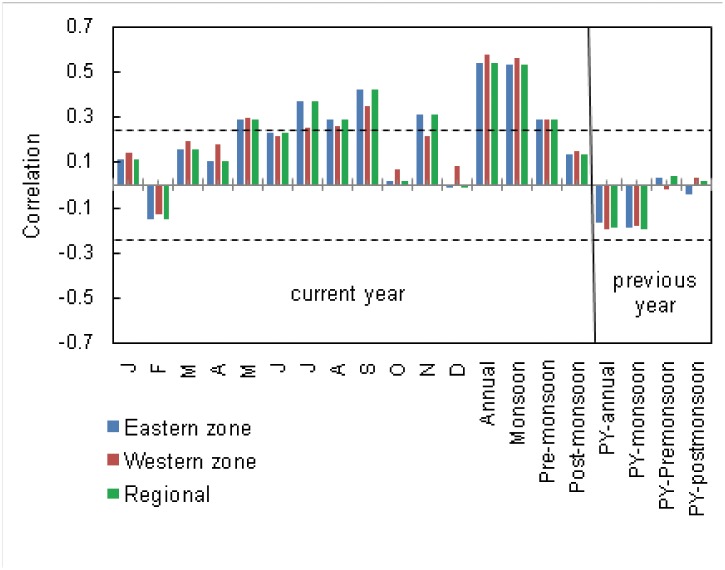
Correlation coefficients between the tree-ring chronologies and precipitation data (1948–2011).The chronology of eastern and western zone was correlated with precipitation of Khulna and Shakhira district, respectively. The regional chronology was correlated with regional (average of both districts) precipitation. For current year, the monthly, annual and seasonal, such as monsoon (June–September), pre-monsoon (March–May) and post-monsoon (October–November) precipitation was used for analysis. In case of previous year (PY-), the annual, monsoon, pre-monsoon and post-monsoon precipitation was used. Dotted horizontal lines indicate 95% significance level and solid vertical line is the boundary between current and previous year.